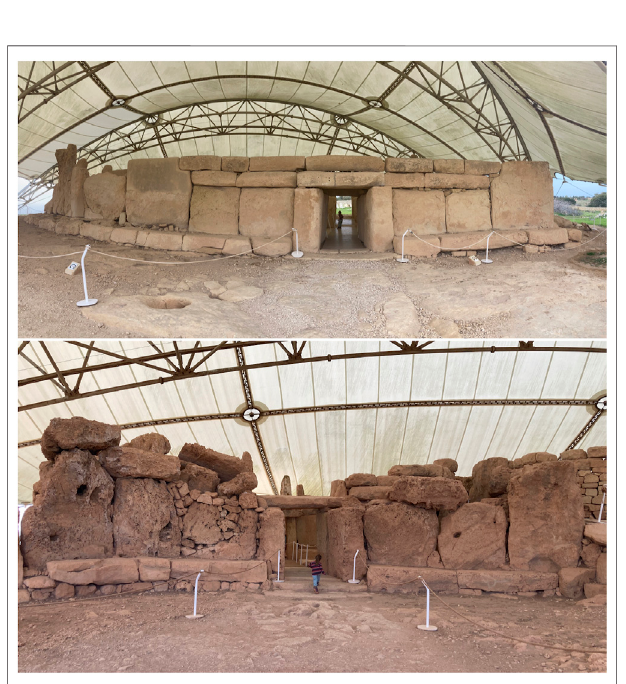
FIGURE2 | ExamplesofMaltese megalithic “ temples. ” Top: Ħ a ġ ar Qim, Bottom: Mnajdra. Human scale: 107 cm high.